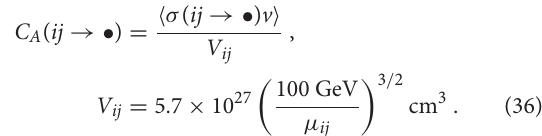
[119], and Jungman et al.